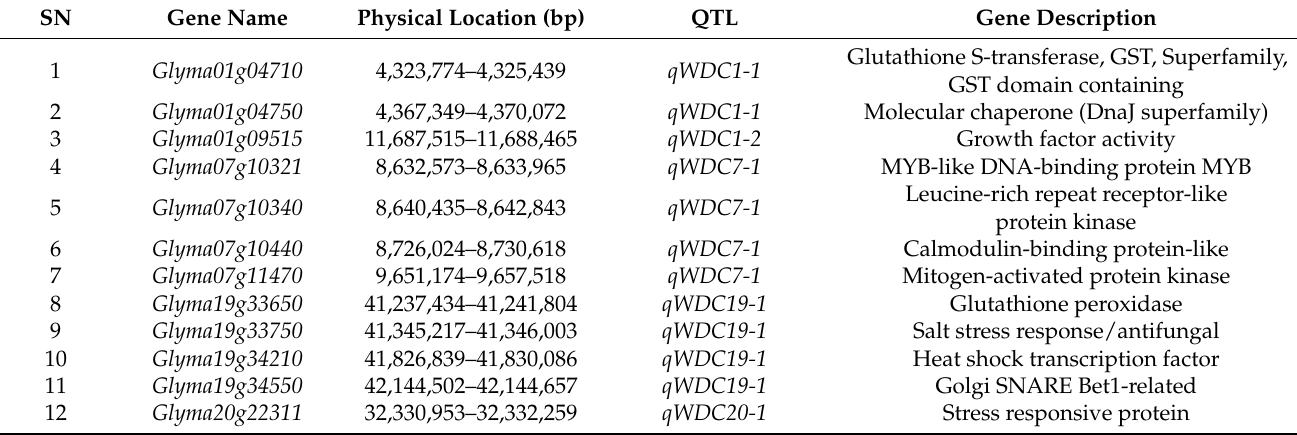
Table 3. Potential candidate genes related to stress tolerance that resided within 200 kb of the QTL